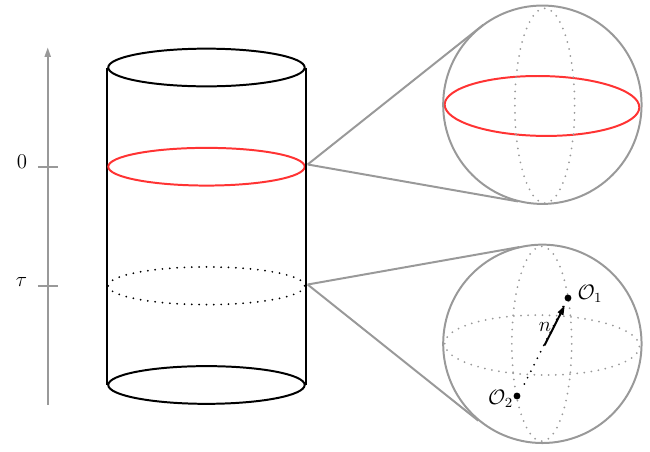
Figure 2 . The con(cid:12)guration corresponding to eq. (2.17). The defect is marked in red, and lies on one equator of the sphere at (cid:28) = 0. The local operators are placed at equal generic time, on the orthogonal equator, in opposite